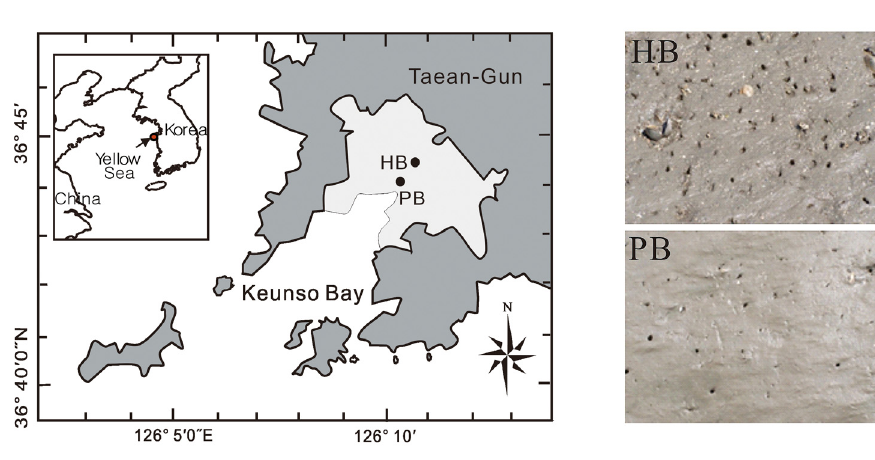
Fig. 1. Study sites of Manila clam aquaculture in the intertidal sediment of Keunso Bay. Light grey: intertidal flats exposed during low tide. Photos: small holes in sediment highly bioturbated (HB) or poorly bioturbated (PB) by Manila tion, or ventilation, of Manila clams ranges from 1.2